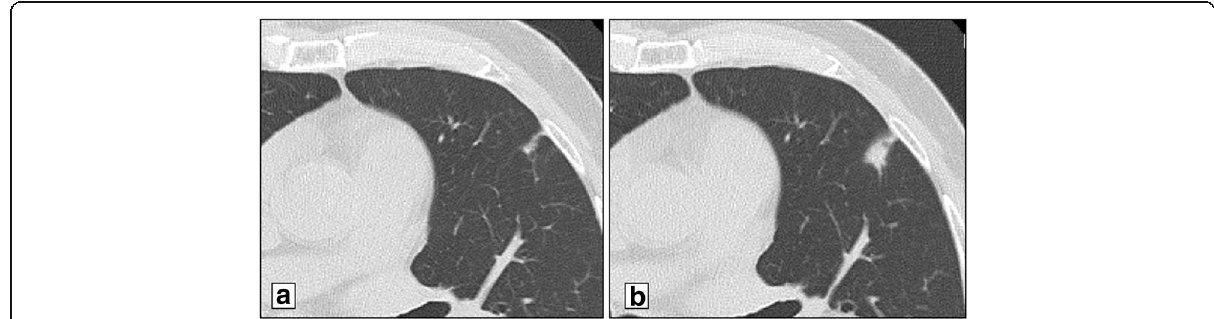
Fig. 3 Imaging studies of the third pulmonary metastasis. Follow-up chest CT (98 months after curative resection of the primary pancreatic tumor) shows a newly appearing nodule in the upper lobe of the left lung ( a ). Chest CT (108 months after curative resection of the primary pancreatic tumor) shows that this nodule has increased ( b ) and appears to be a pulmonary metastasis from PDAC